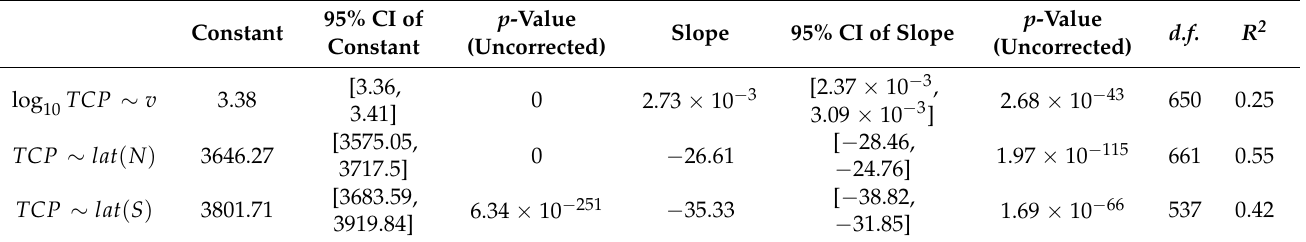
Figure A1. The scatter of tropical cyclone rainfall and tropical cyclone characteristics and their linear trends. ( a ) Maximum wind speed. ( b ) Latitude in Northern Hemisphere and ( c ) Southern Hemisphere. Table A1. Statistical significance of the relationship between tropical cyclone rainfall and main